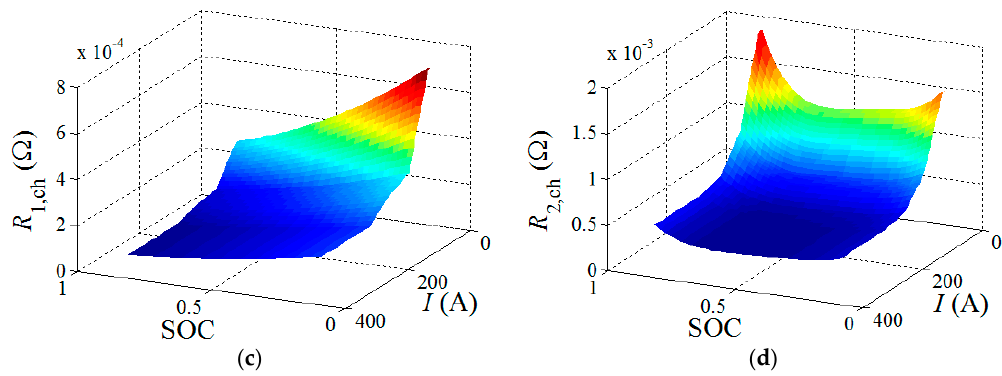
Figure 6. Contour plots of 2D look-up tables for each parameter at different SOC and current including ( a ) R 1,dis ; ( b ) R 2,dis ; ( c ) R 1,ch , and ( d ) R 2,ch .